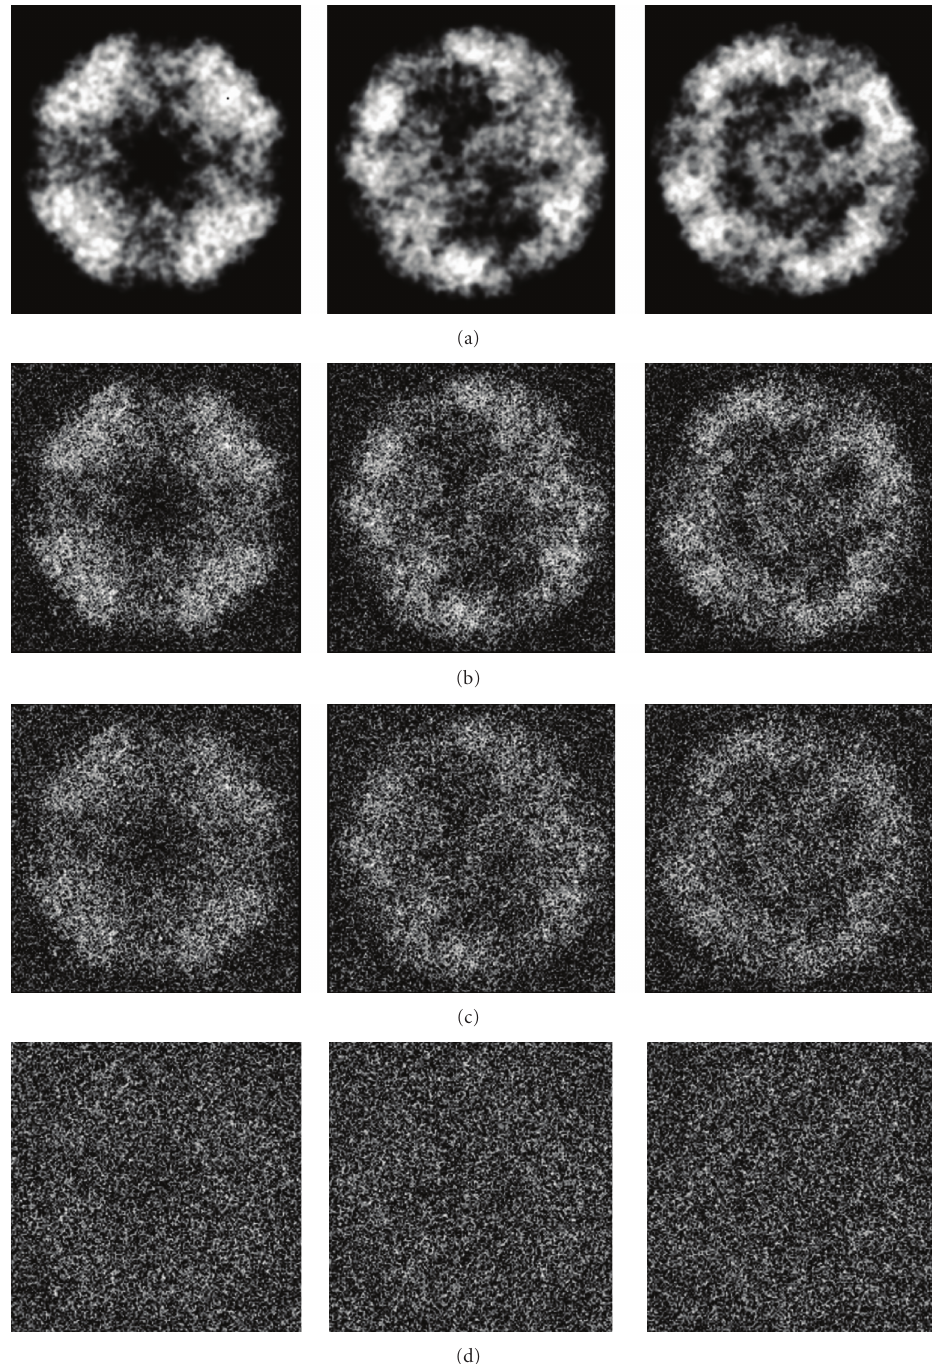
Figure 2: Three representative projection images of the DegP 24 model generated from PDB data. (a) Without noise, (b) with S / N = 0.8, (c) with S / N = 0.5, (d) with S / N =